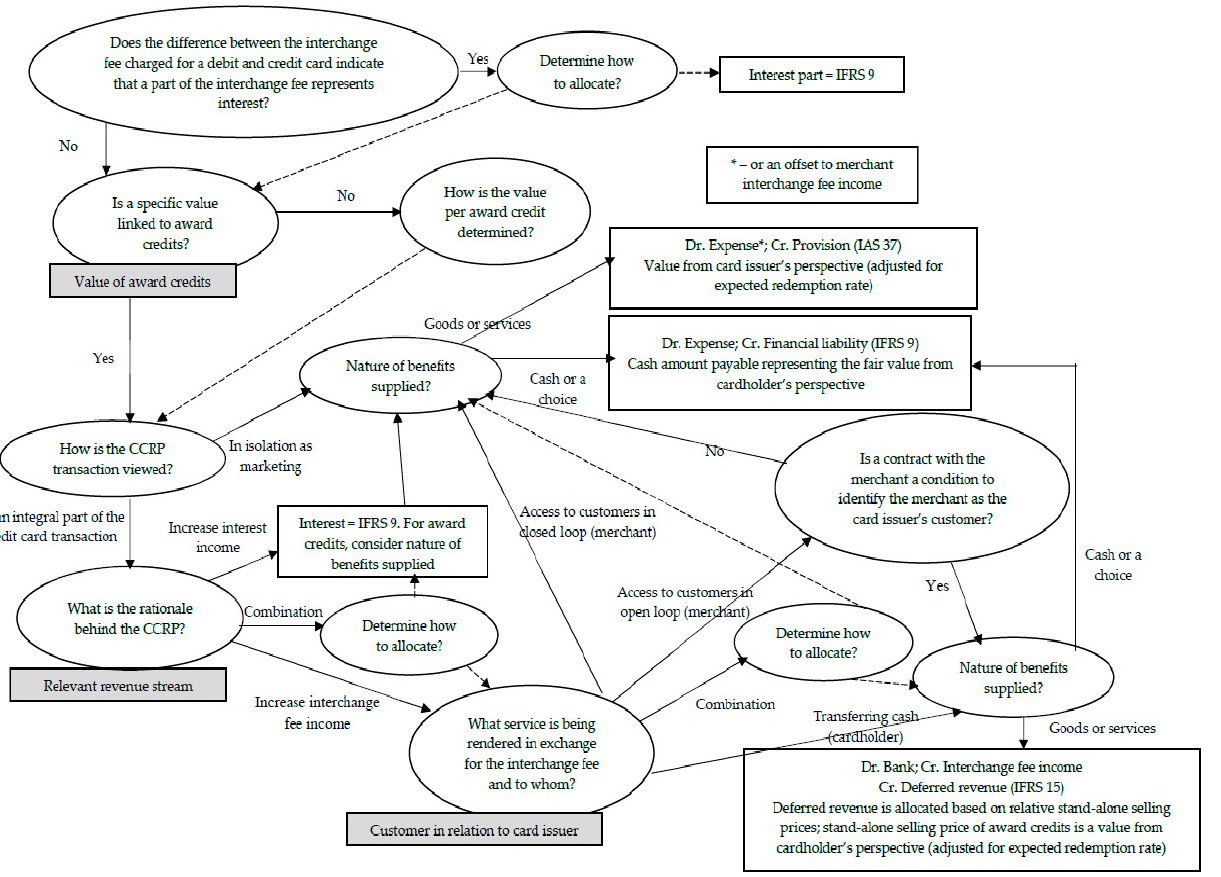
Figure 12. CCRP theoretical model.